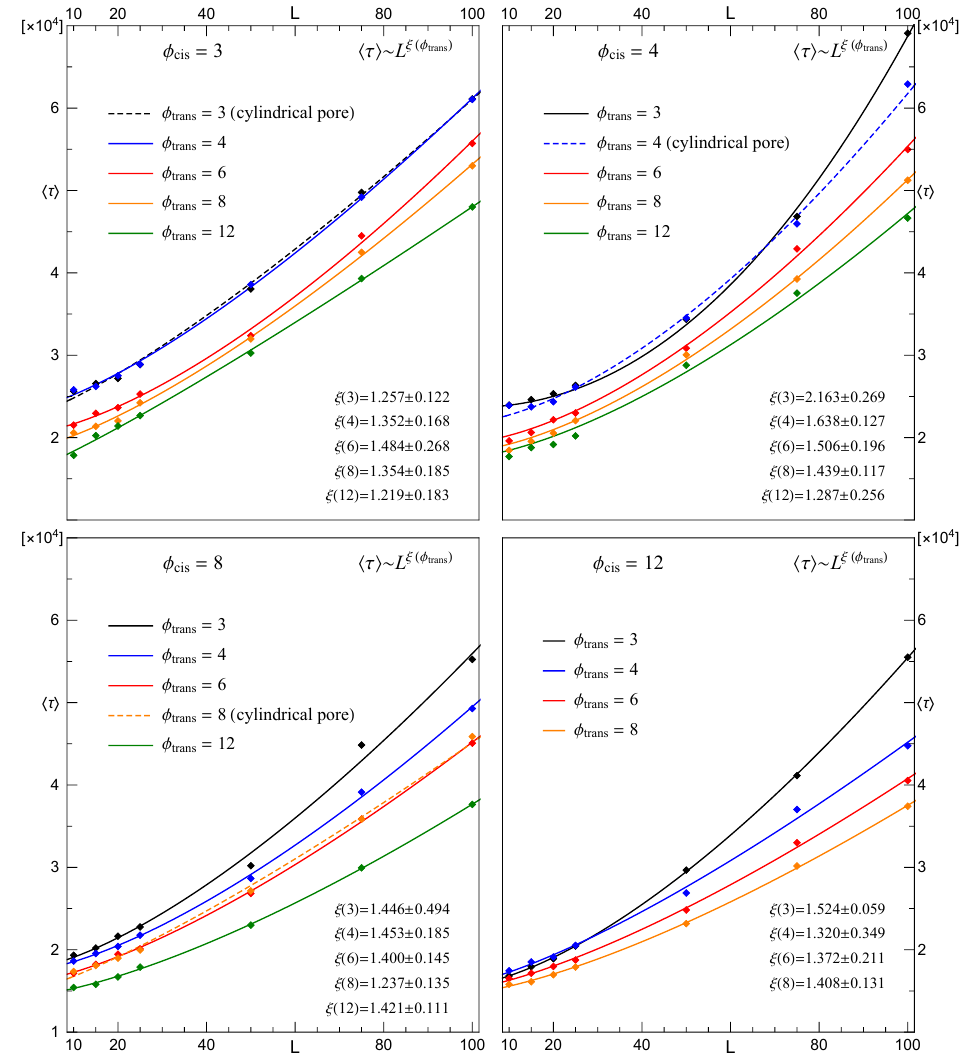
Figure 6. The same as in Figure 4. Each panel corresponds to φ cis = const. and growing φ trans .